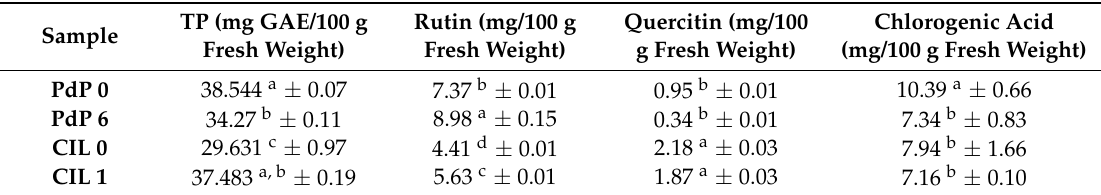
Table 3. Total phenolic (TP) compounds, rutin, quercitin and chlorogenic acid (mean ± standard deviation) in tomato